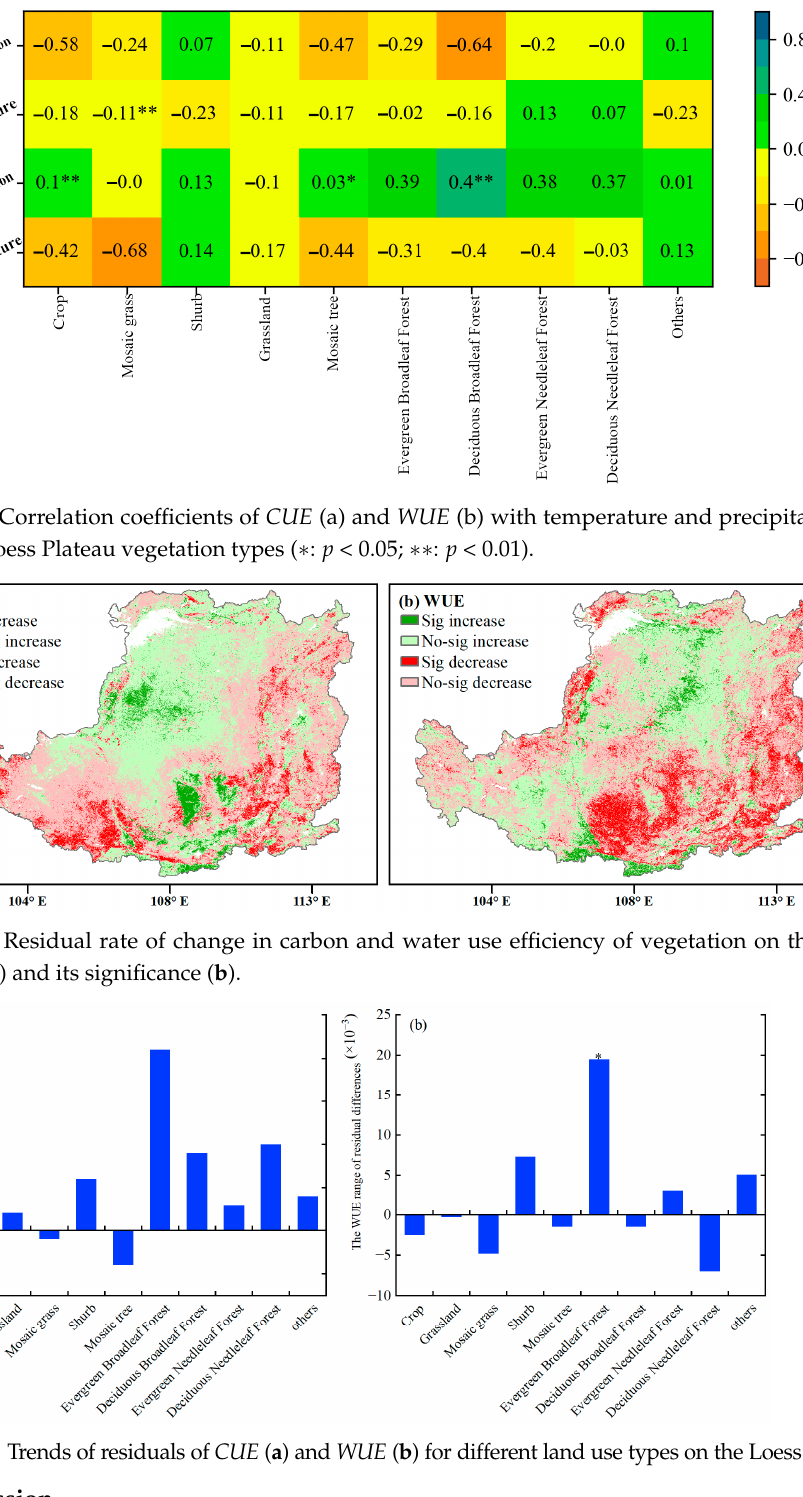
Figure 10. Trends of residuals of CUE ( a ) and WUE ( b ) for different land use types on the Loess Plateau.